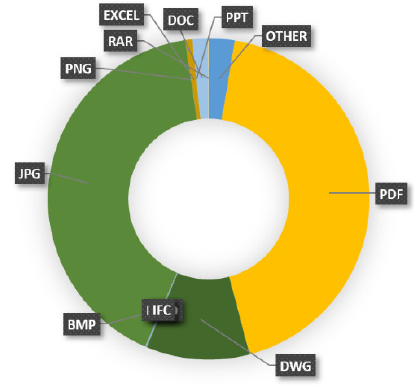
Figure 14. Temporal evolution of the number of items in the common data environment.